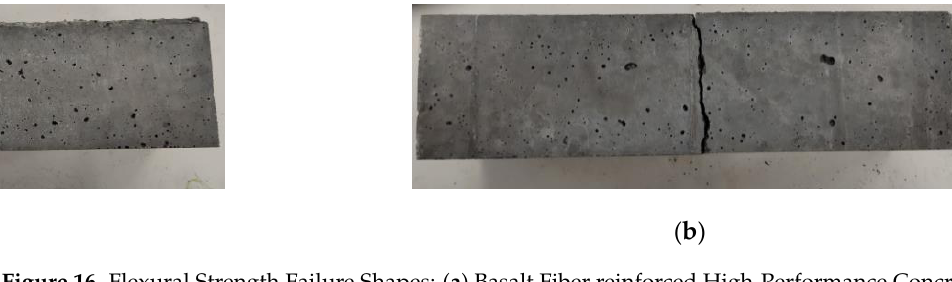
Figure 16. Flexural Strength Failure Shapes: ( a ) Basalt Fiber reinforced High-Performance Concrete; ( b ) High-Performance Concrete.